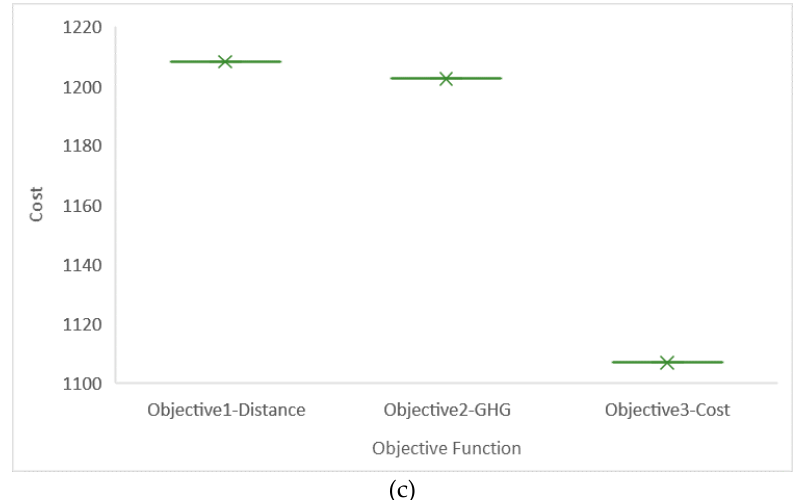
Figure 7. Results comparison with different objectives. ( a ) Objective1-minimized distance, ( b ) Objective2-minimized GHG and ( c ) Objective1-minimized cost.